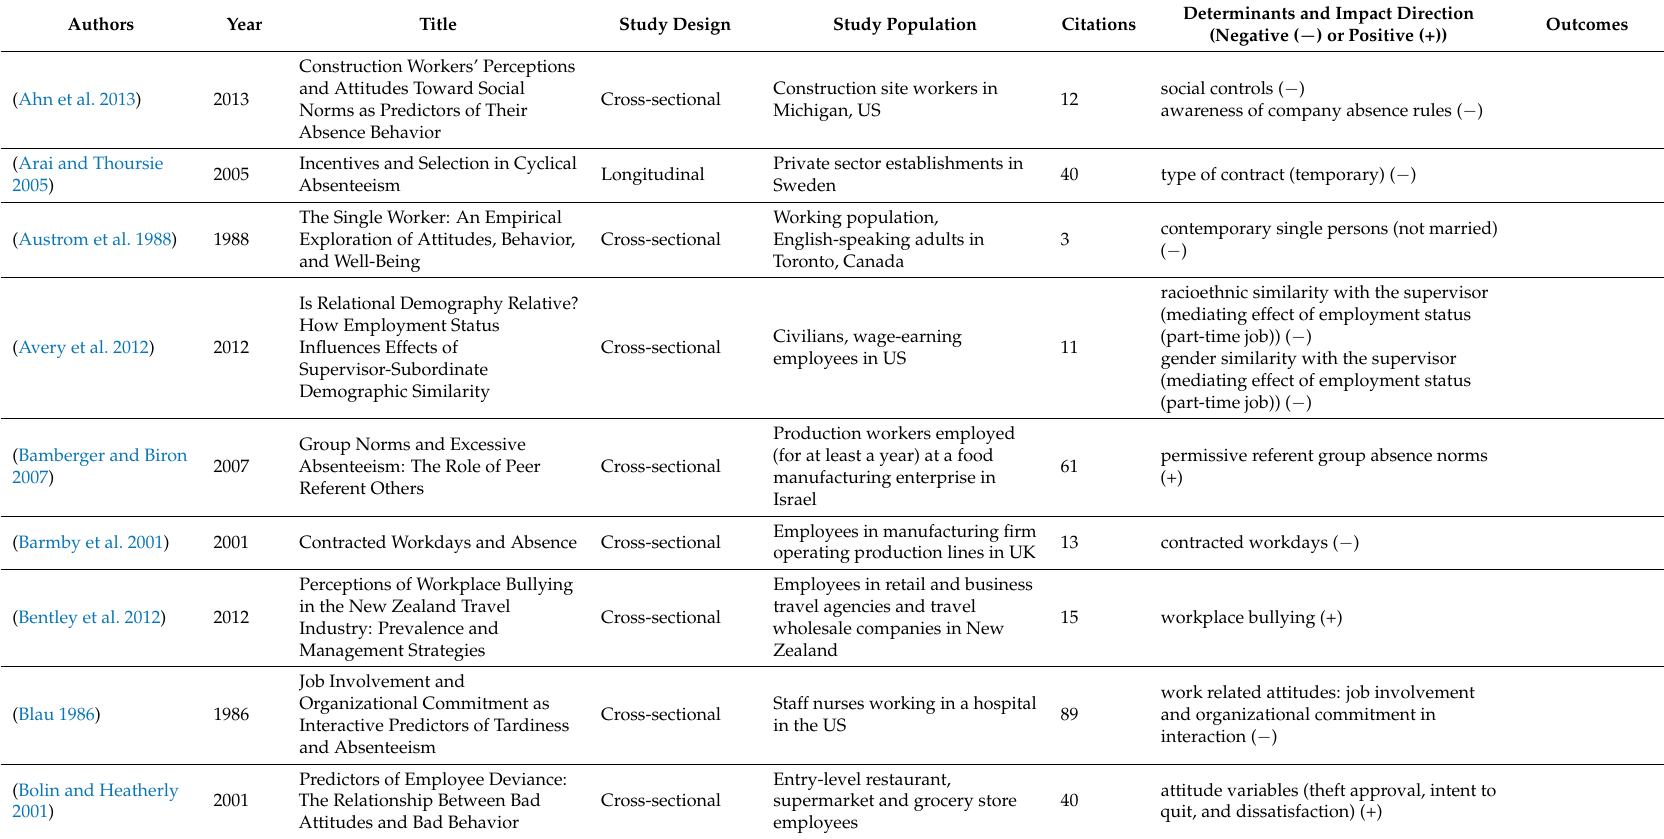
Table 1. Absenteeism determinants and